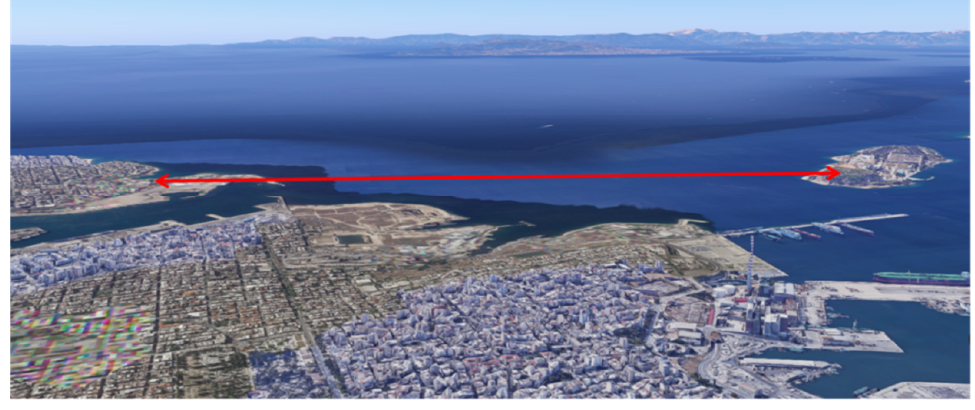
Figure 1. Overview of the link. Table 1. FSO system specifications.